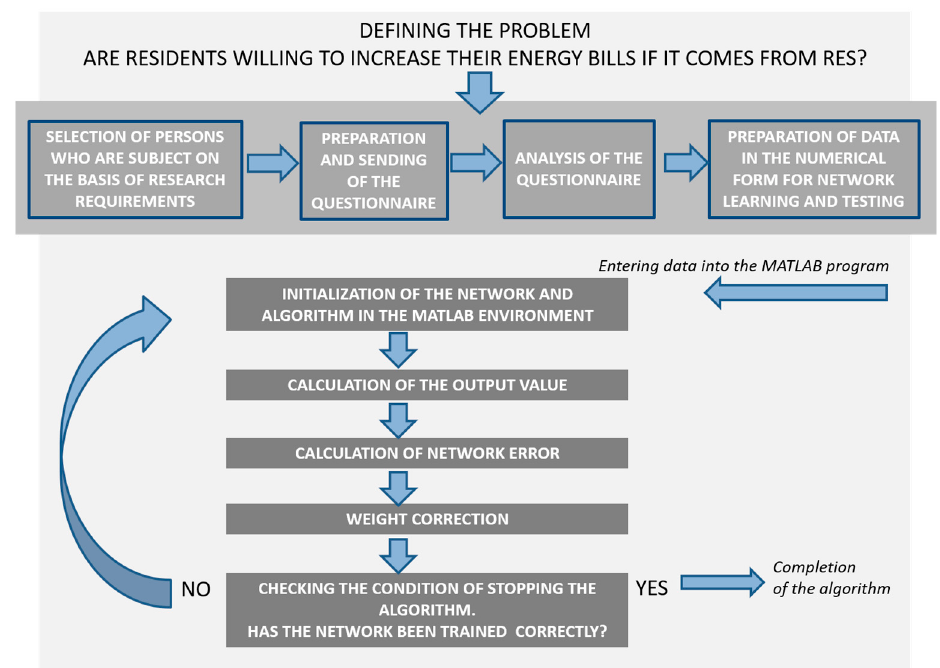
Figure 5. A neural-network-based model of linking the database with the objective to increase in energy efficiency and introduction of RES and local policy directions.